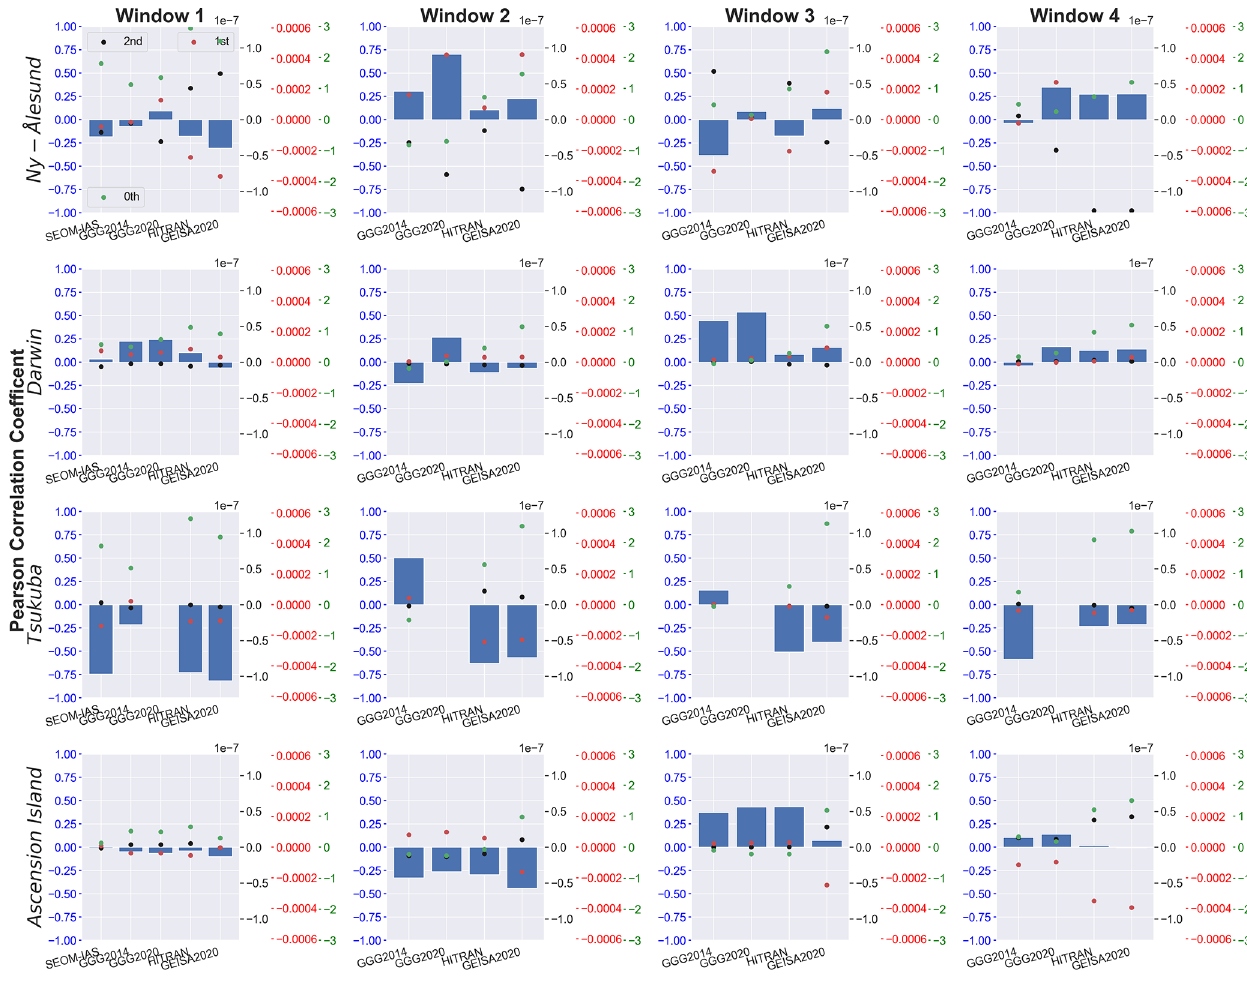
Figure 11. As Fig. 10 but showing the sensitivities to water vapour